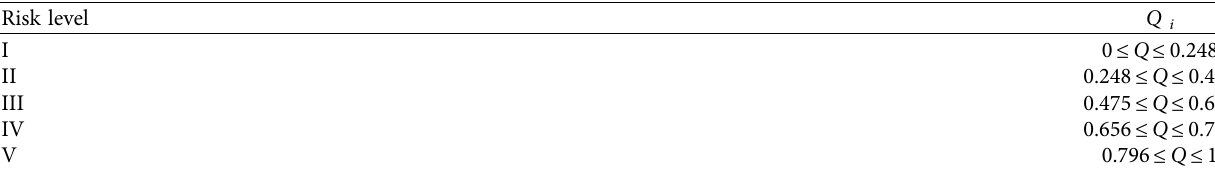
Table 13: Te risk level classifcation.